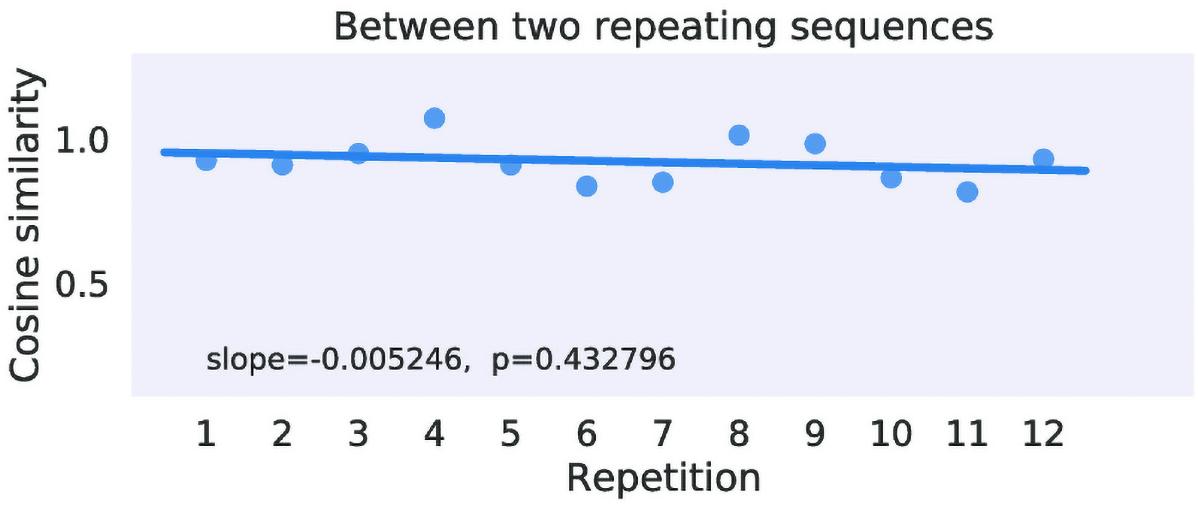
Fig 9. Change in pattern distance across trials for a single participant and region. Y -axis displays the distance value, while x -axis the trial